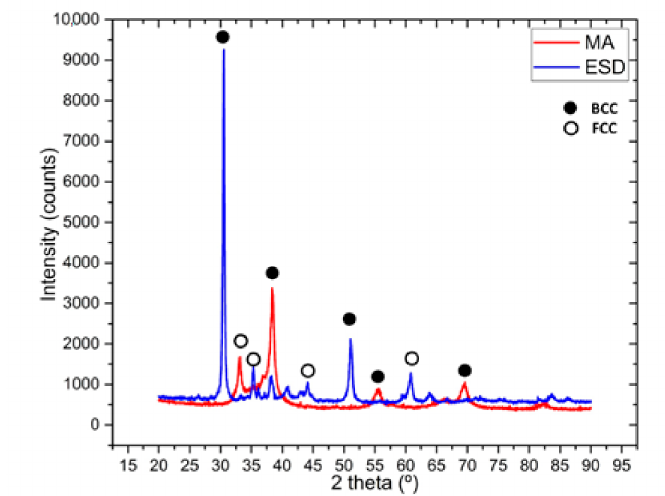
Figure 3. XRD analysis results for the mechanically alloyed HfNbTaTiZr high-entropy alloy after 60 h of milling time and the electrospark deposited sample.